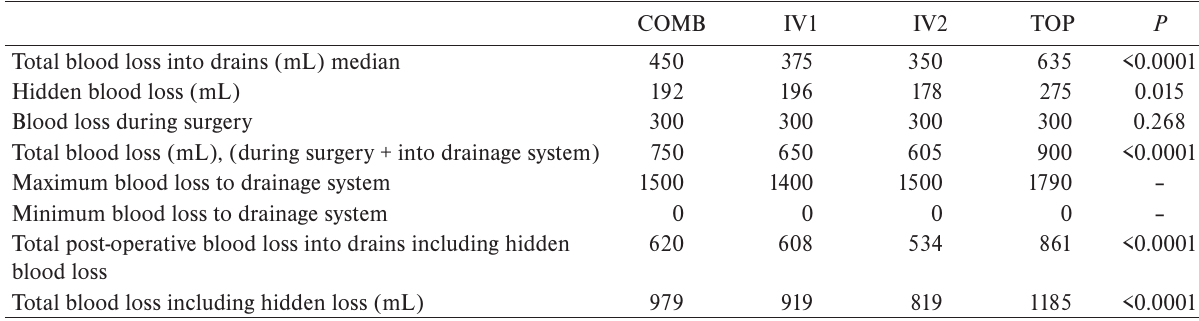
Table 2. Overview of perioperative blood loss.